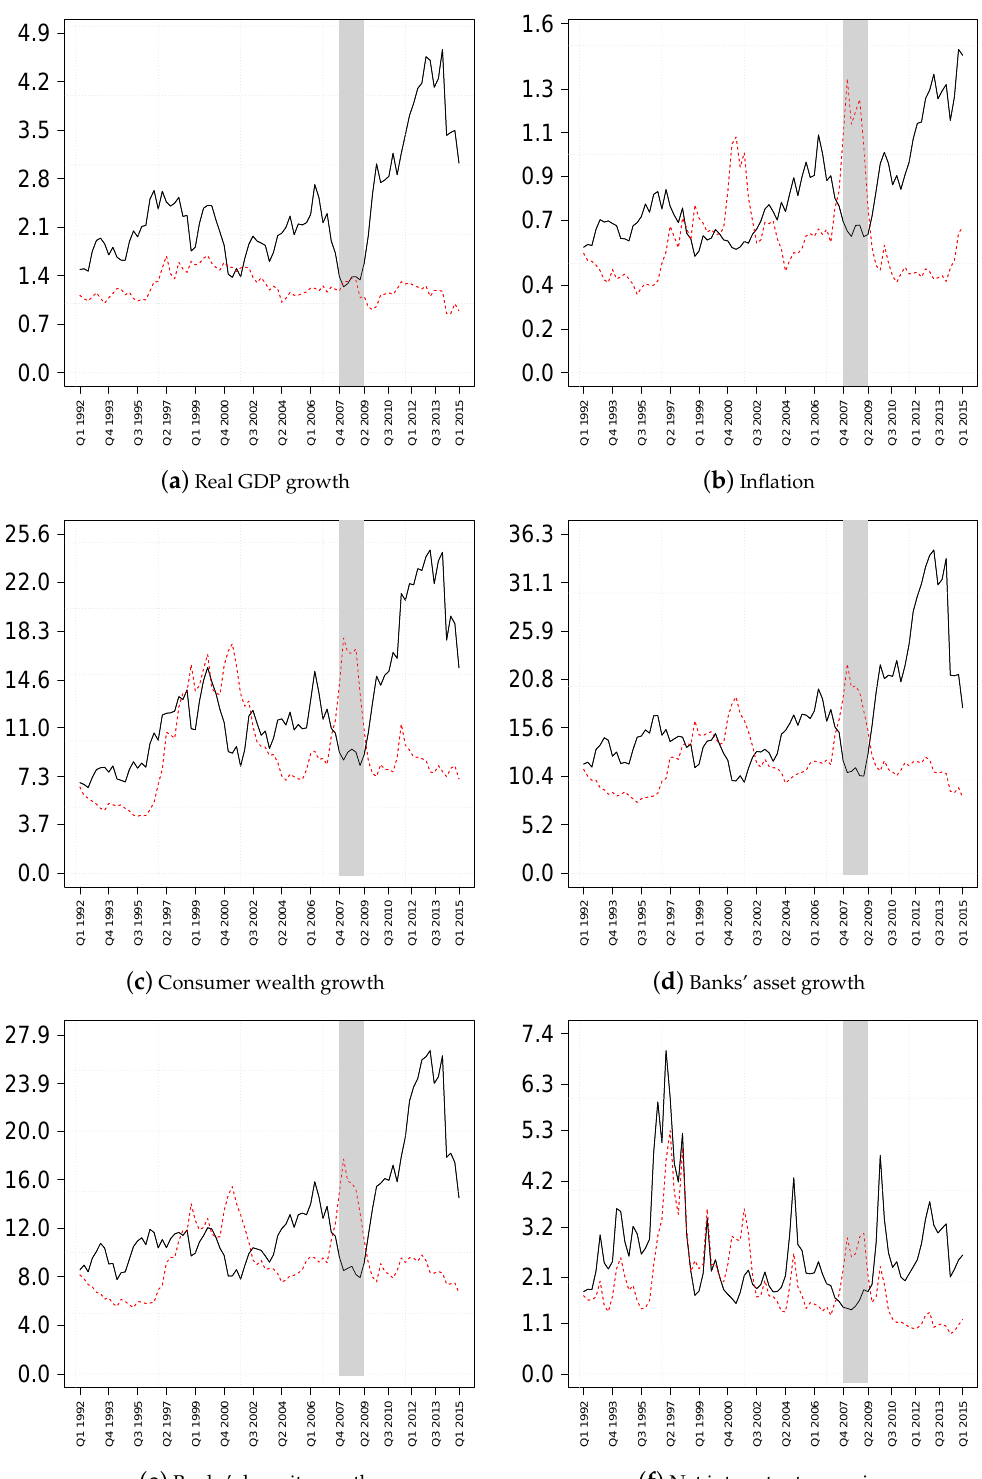
Figure 4. Elasticity of cumulative response to the size of shock on impact. Notes: The figure shows the ratio of the cumulative response of particular variable to the impact shock of the conventional monetary policy shock (black, solid line) and the spread shock (red, dashed line). Elasticities are in absolute terms. The shaded grey area indicates the period of the recession associated with the global financial